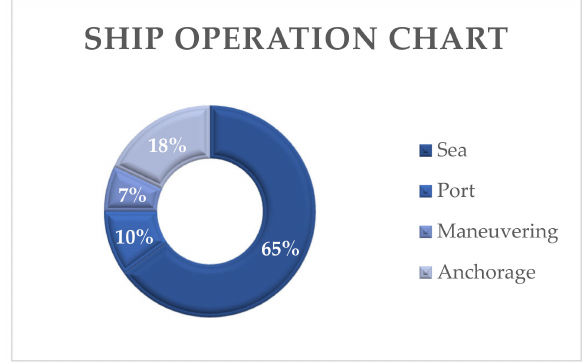
Figure 4. The operation chart of the